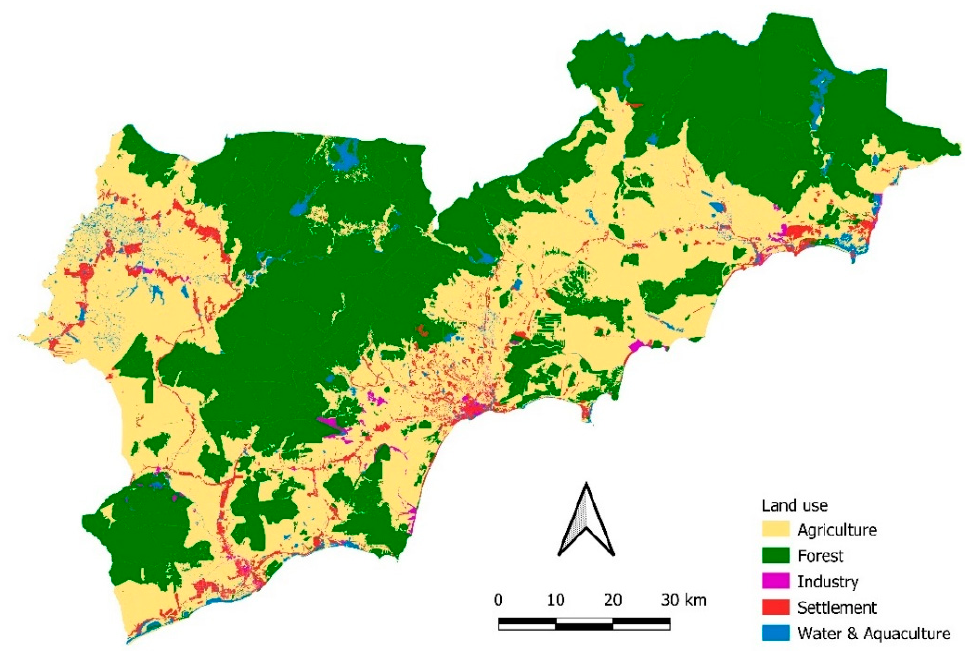
Figure 6. Major land use types in 2010 in Binh Thuan province, Vietnam. Table 3. Area (in ha) of major land use types in Binh Thuan province (1998–2018), based on own analysis of statistical data [1].